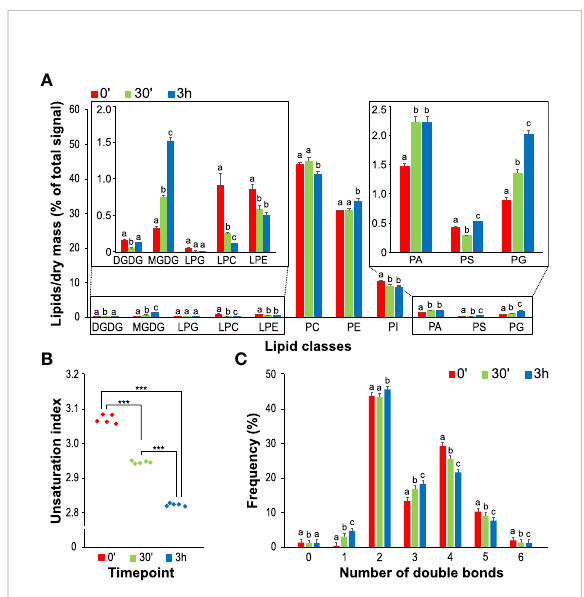
FIGURE 2 Changes in glycerolipid classes during the process of pollen germination and pollen tube elongation. (A) The composition of the main lipid classes (DGDG, MGDG, PG, PC, LPG, LPC, LPE, PE, PI, PS and PA) at different time points during the germination process of pollen tubes. The inset shows the composition of selected lipid classes in more detail. Data are presented as mean ± sd, n=4 (0 ’ ) and n=5 (30 ’ and 3h). Different letters indicate signi fi cant differences between samples at p < 0.05. (B) Changes of total unsaturation index during the different timepoints. (C) Double bonds distribution in the different time points. Asterisks (***) represent the signi fi cance between samples at p <